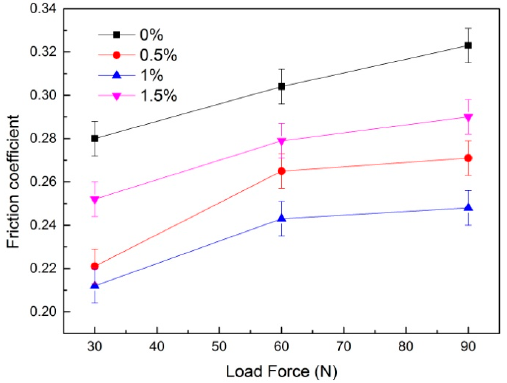
Figure 9. Friction coefficients of the tested alloys under different applied loads.